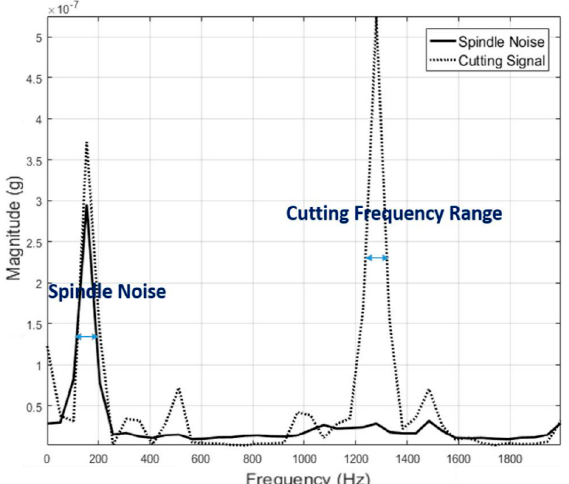
Figure 5. Vibration signal from finishing process overlapped on spindle noise.